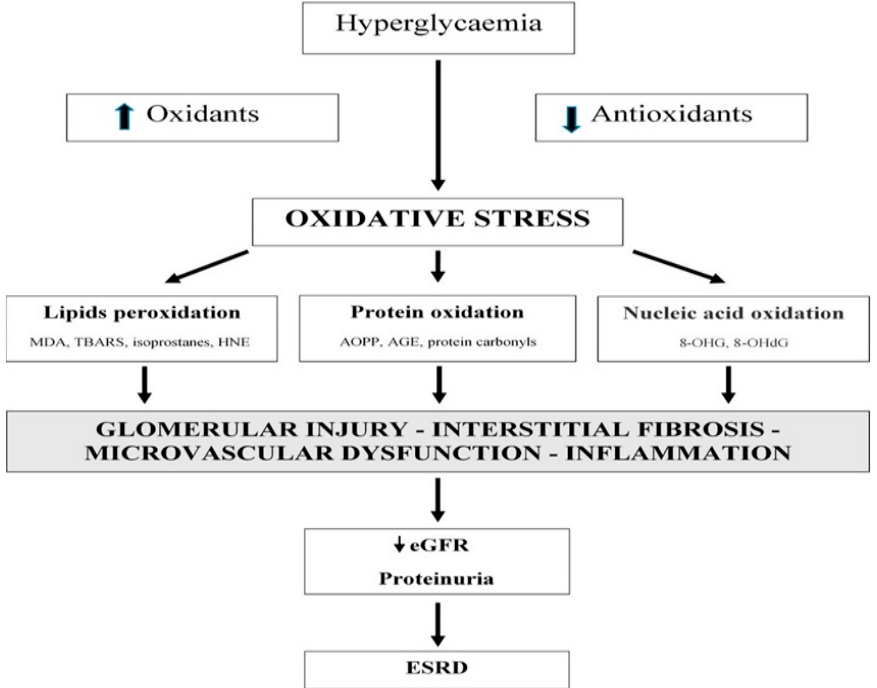
Figure 1. Increased glucose level can lead to end-stage renal disease. Hyperglycemia leads to oxida- tive stress which in turn activates elevated levels of lipid peroxidation, protein oxidation, and nucleic acid peroxidation that leads toward glomerular injury, then interstitial fibrosis to microvascular dysfunction and finally inflammation which further downregulate eGFR proteinuria and finally end-stage renal disease.